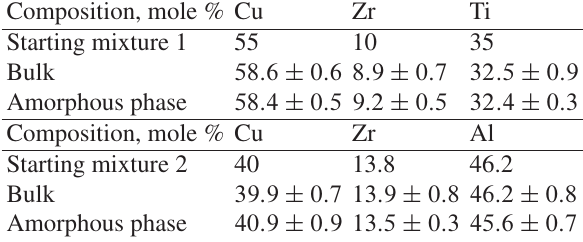
Table 1. Compositions of alloys, obtained in-situ during electromagnetic